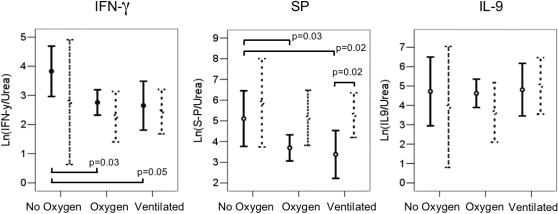
Nasopharyngeal concentrations of IFN-γ, SP, and IL-9 (expressed Ln([cytokine]/[urea]), ng/mol, geometric mean and 95% confidence intervals), in 185 infants grouped by severity of bronchiolitis and sub-grouped by term (solid lines) or preterm birth (dashed lines).Horizontal bars indicate between group comparisons by t-test and calculated p values.